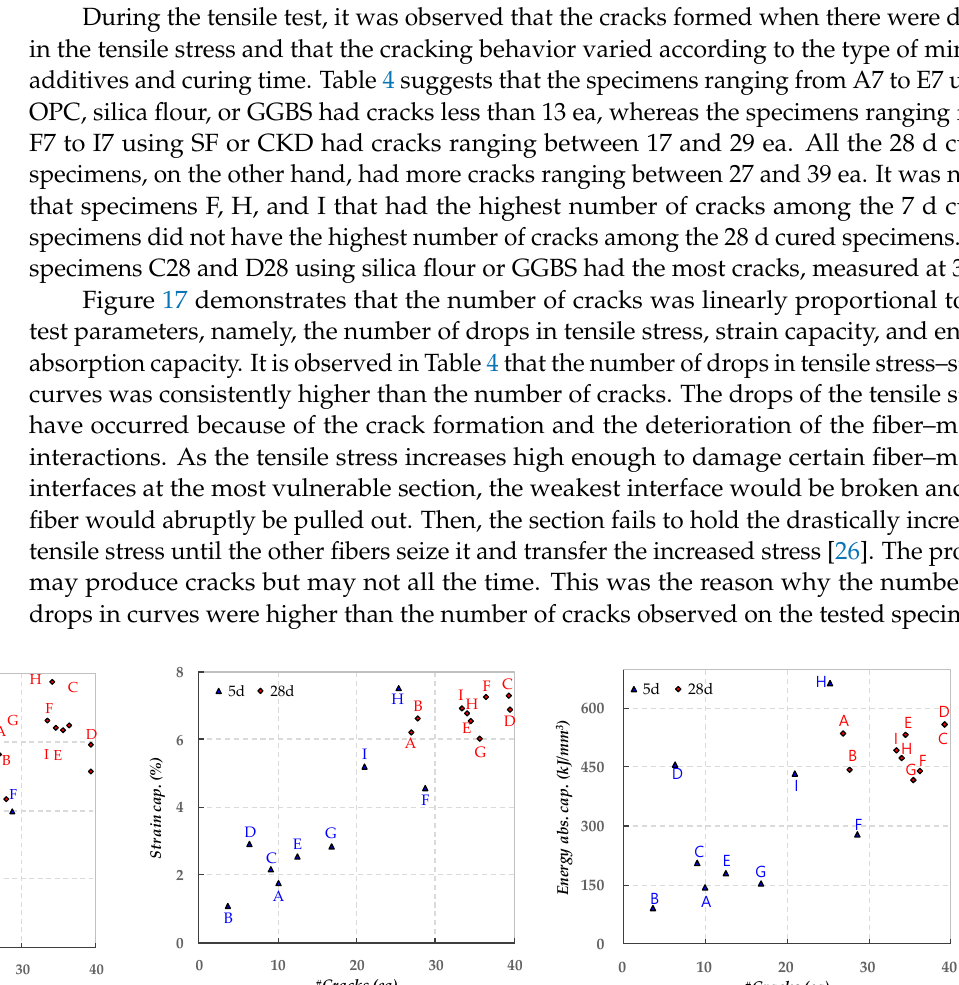
Figure 16. Representative cracking behaviors of ( a ) 7 d and ( b ) 28 d cured specimens.